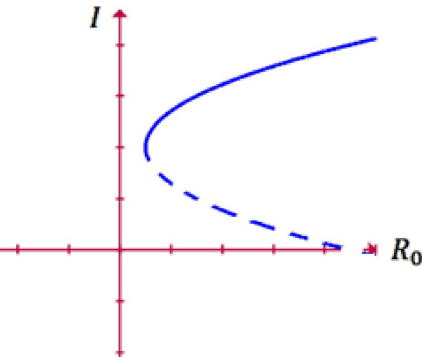
Figure 1. Saddle node